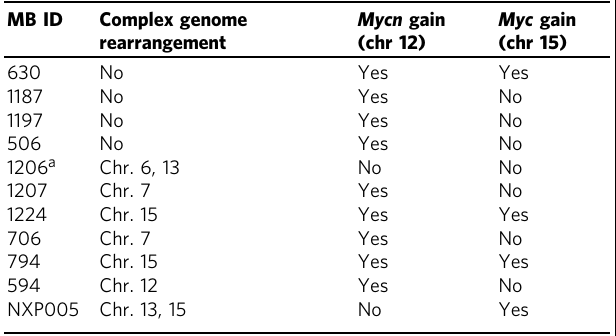
Table 1 Complex genome rearrangements and gains of Myc/ Mycn in Nestin-cre p53 − / − Xrcc4 − / −